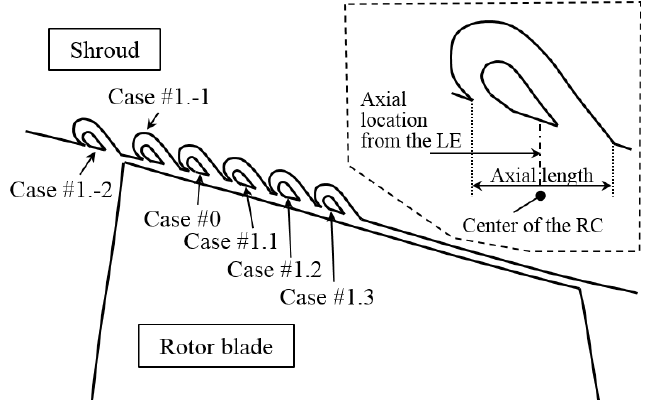
Figure 5. Schematic of locating the RC at different axial positions on the meridional plane. Table 3. Parametric study of the recirculation channel location on the rotor shroud wall.